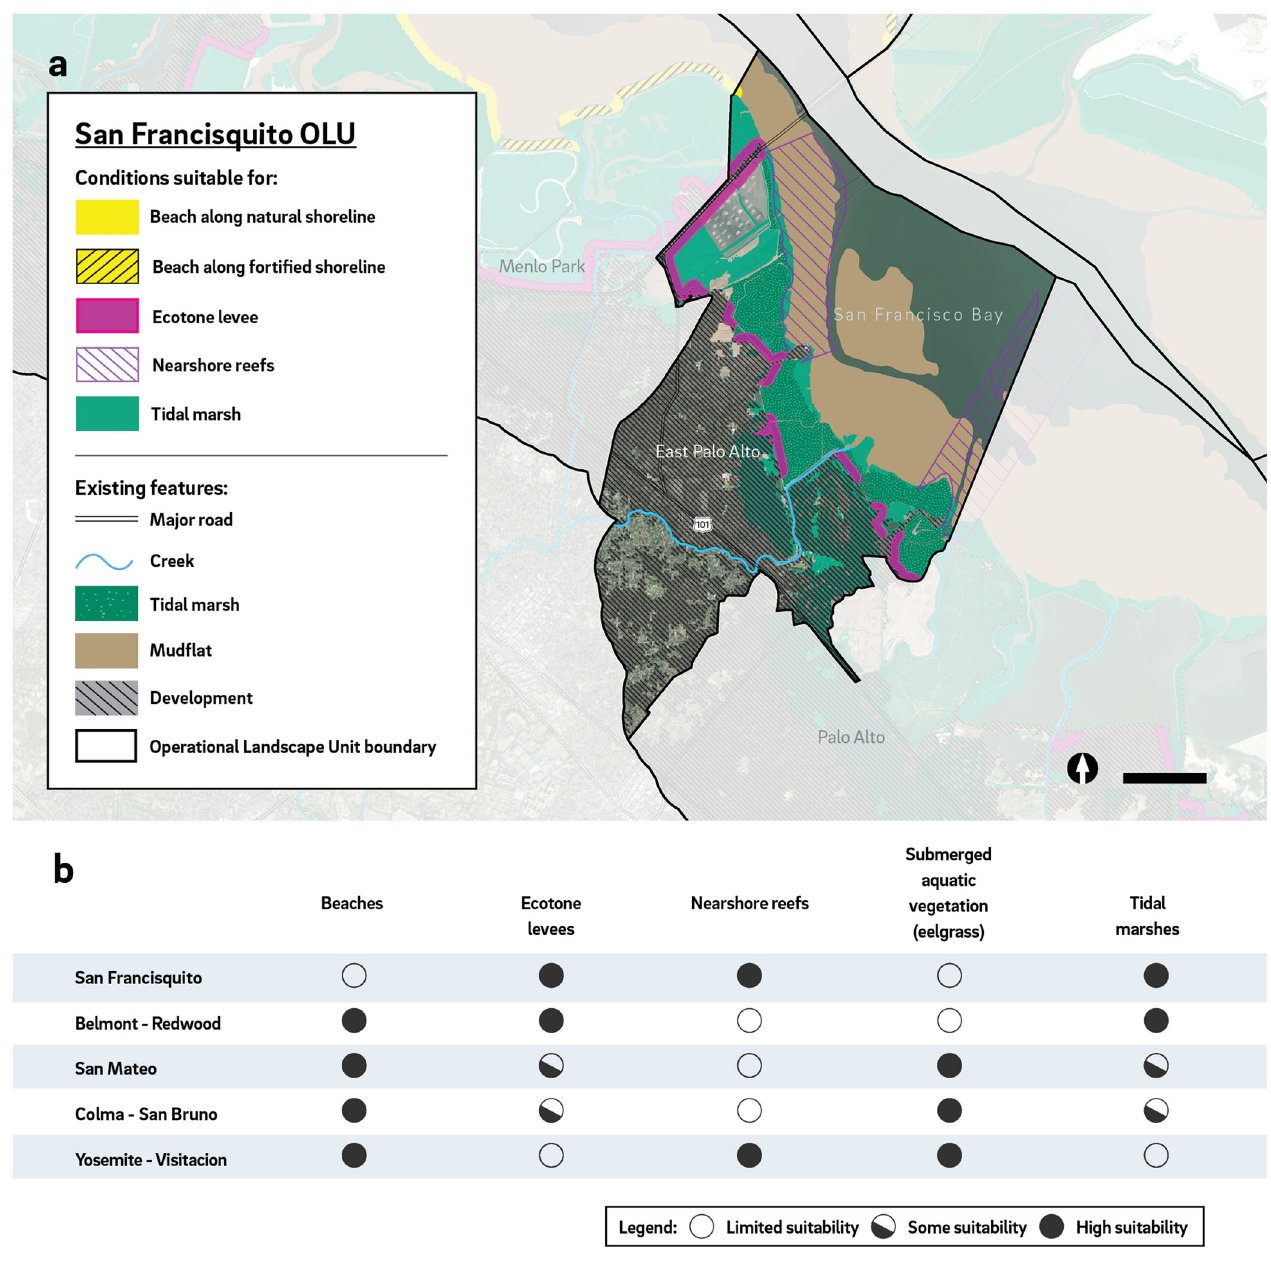
Fig. 3 Biophysical suitability of nature-based adaptation opportunities — particularly ecotone levees, nearshore reefs, and tidal marshes. a Suitability in San Francisquito and b throughout the County ’ s 5 OLUs (also including beaches and submerged aquatic vegetation). Neighboring regions are masked, but show differences: for example, the suitability of long stretches of the Belmont-Redwood OLU shoreline to the northwest for beaches along both natural and forti fi ed shorelines. We summarized biophysical suitabilities by OLU from the regional suitability assessment in the San Francisco Bay Shoreline Adaptation Atlas 24 . Black scale bar in panel ( a ) represents 1